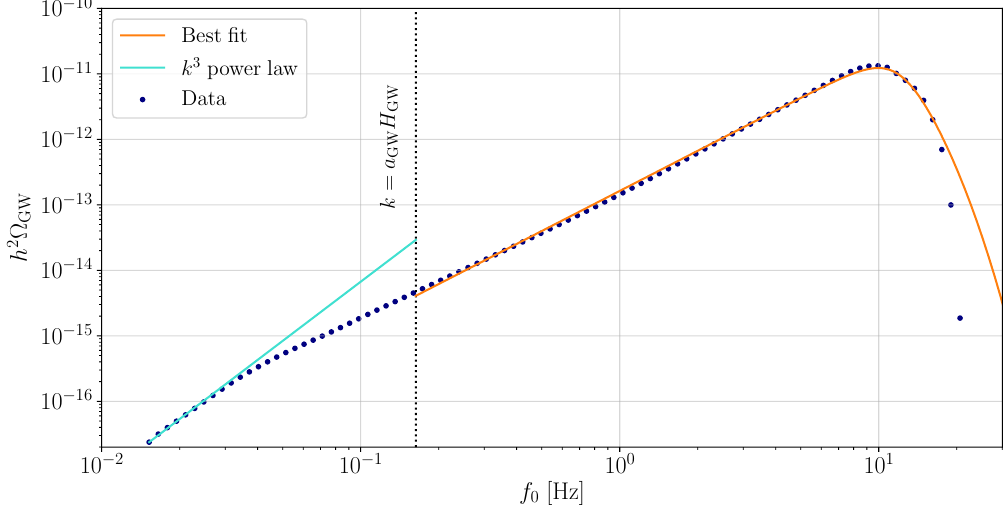
Figure 6: Simulated (blue dots) and fitted (orange line) spectrum for benchmark 2. The fit template is given by Eq. (46). At low frequencies, below the Hubble rate at the time of production indicated by the dotted vertical line, the spectrum deviates from the template, exhibiting the f 3 behavior indicated by the light blue line and expected from causality. When fitting the spectrum, this frequency region is hence not taken into account. The template however still captures well the spectral shape around the peak, which is the region relevant for determining the observability of the